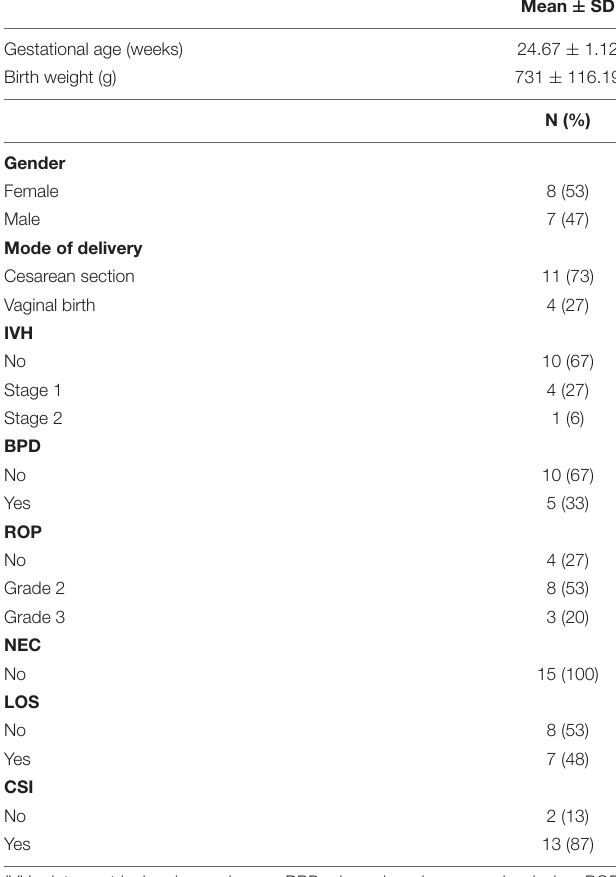
TABLE 1 | Summary of cohort